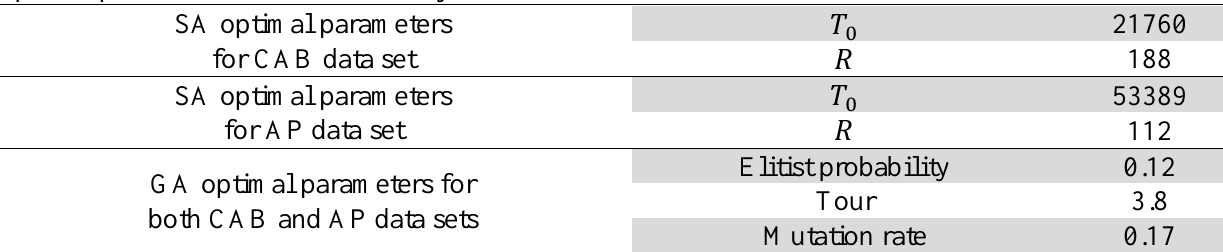
Optimal parameter values obtained by RSM for SA and GA SA optimal